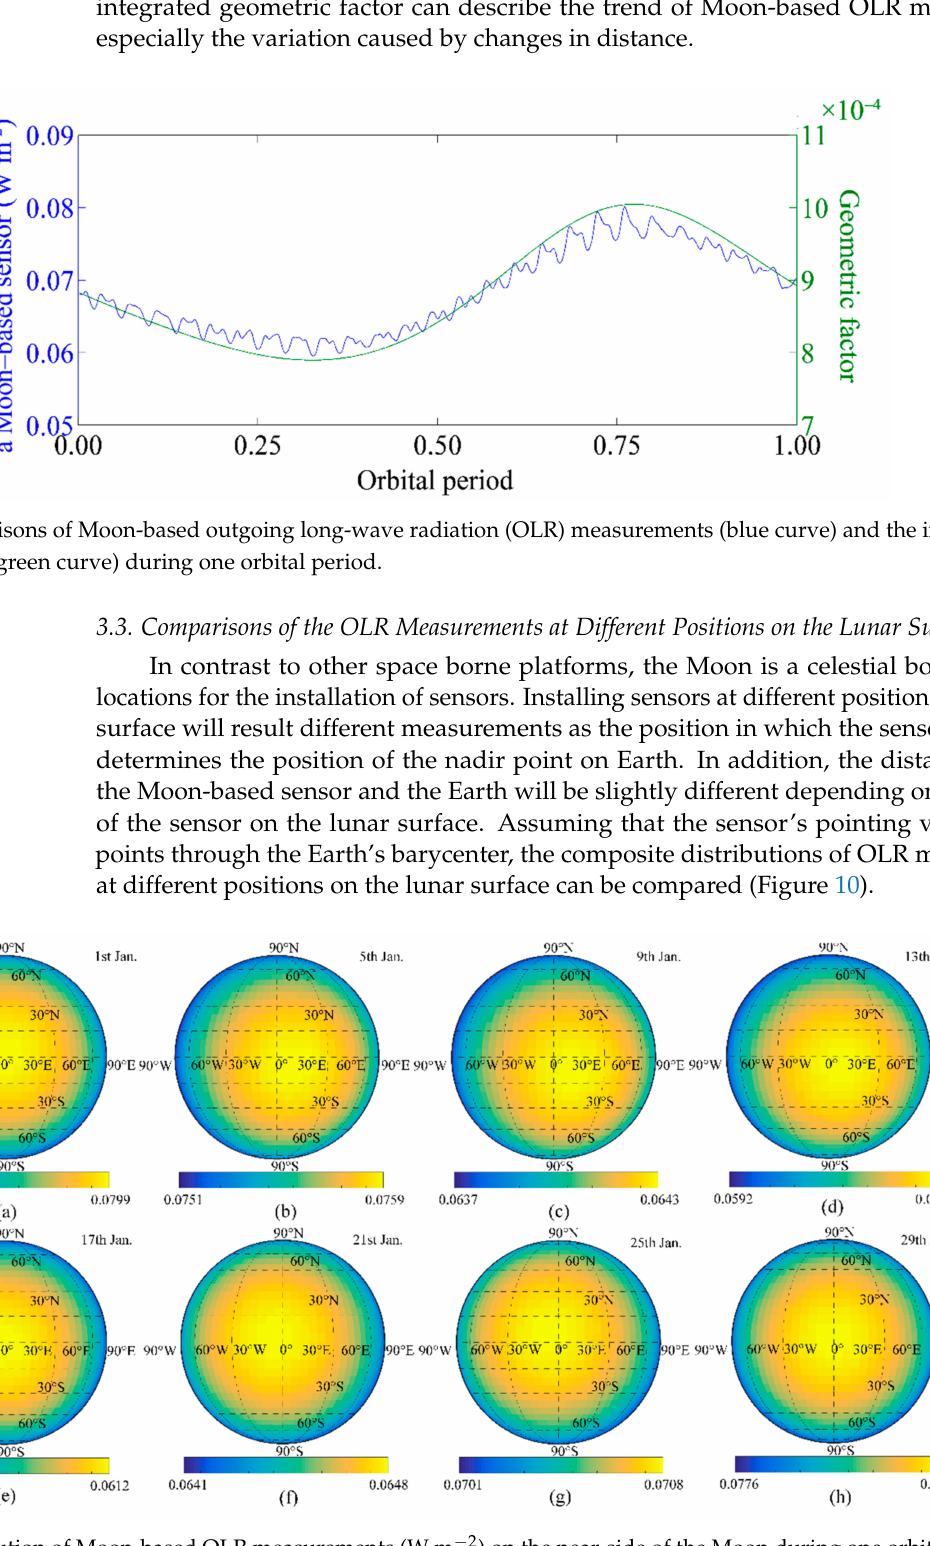
Figure 10. Distribution of Moon-based OLR measurements (W m − 2 ) on the near-side of the Moon during one orbital period; ( a – h ) represent the distribution for January 2020, with an interval of four